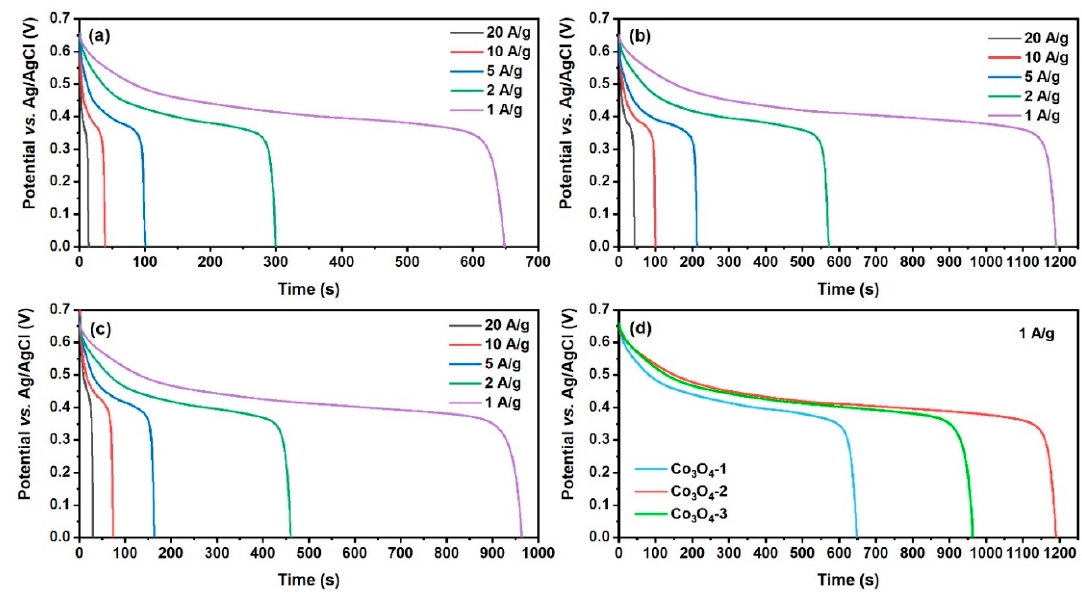
Figure 4. Discharge curves at representative current densities ranging from 1 to 20 A/g: ( a ) Co 3 O 4 -1, ( b ) Co 3 O 4 -2, ( c ) Co 3 O 4 -3; ( d ) discharge curves of Co 3 O 4 -1, Co 3 O 4 -2 and Co 3 O 4 -3 electrodes at current density of 1 A/g.